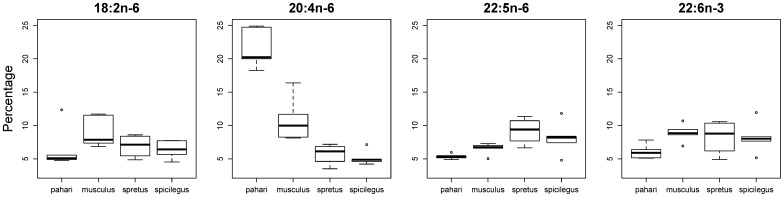
Percentage of the most abundant polyunsaturated fatty acids in sperm cells.The four polyunsaturated fatty acids that compose more than 5% of the fatty acids in sperm cells are represented. The modified boxplots present the following information: the bar within each box represents the sample median, each box represents 50% of the data around the median, and the two whiskers around each box represent the 95% confidence interval (n = 5 for each species, except n = 4 in the case of sperm data for M. spretus); circles represent outliers.